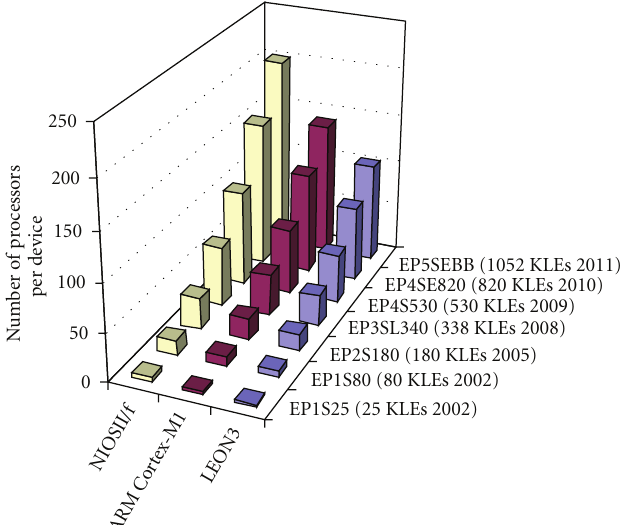
Figure 1: Evolution in the capacity of integration of Altera devices with respect to the theoretical number of soft-core processors that they might host.